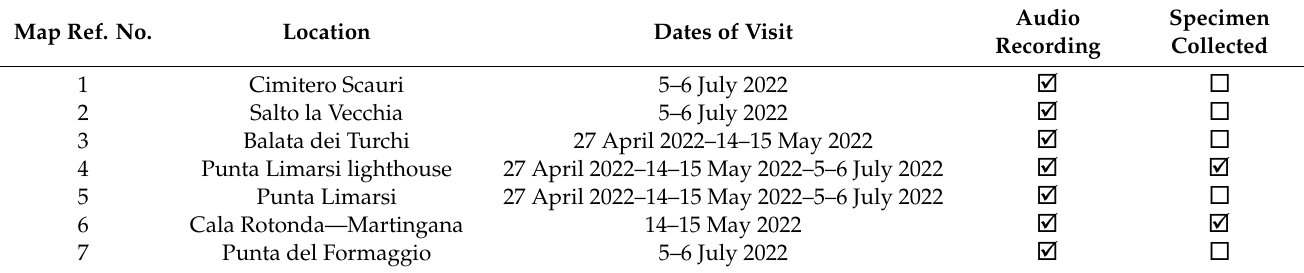
Table 1. List of localities cited in the text, with dates and kind of evidence collected. Map Ref. No.